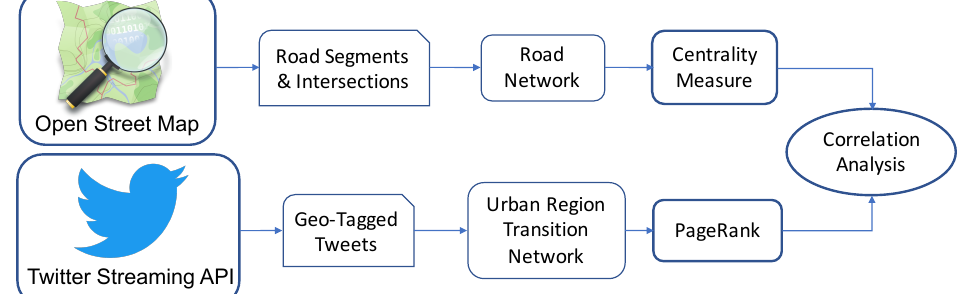
Figure 1. The methodology framework of our study. For road network centrality, we collected data from OpenStreetMap, parse to get road segments and intersections, formulate a graph (undirected or directed) by taking road segments as edges and intersections as nodes, and calculate various centrality measures. For human urban mobility intensity, we collected geo-tagged tweets as a proxy of human movements, designed an urban region transition network to capture the human movement flow across urban areas, and then applied a personalized PageRank algorithm to measure the intensity of urban mobility. Finally, we conducted a ranking correlation analysis between the